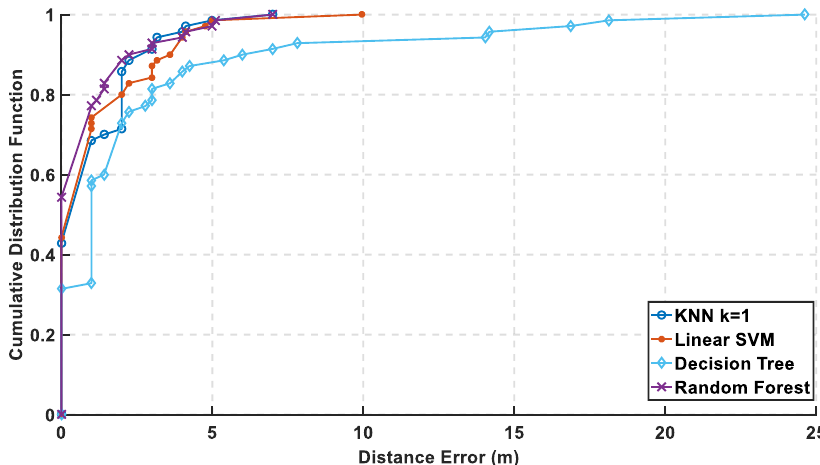
Figure 12. Mean Error Versus the Machine Learning Approach with and without PCA.